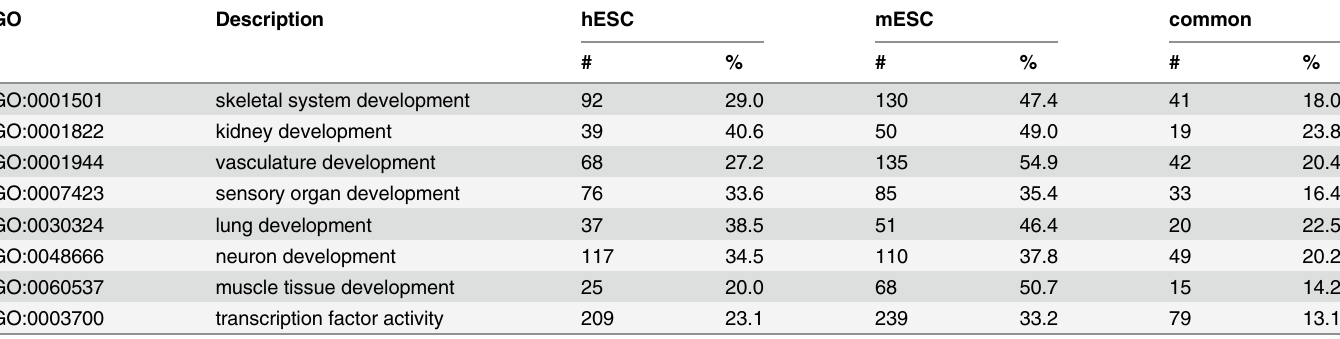
Percentage of genes is to total number of genes in respective GO category, which may be different in the two organisms. Percentage for common genes is to the number of common orthologous genes in the GO